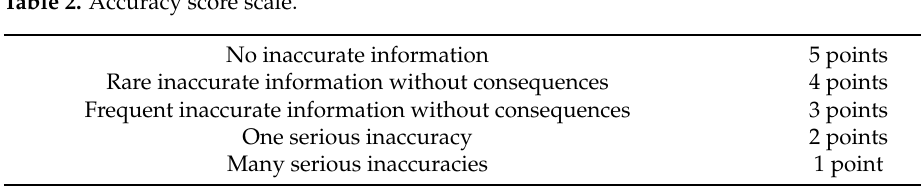
Table 2. Accuracy score scale.